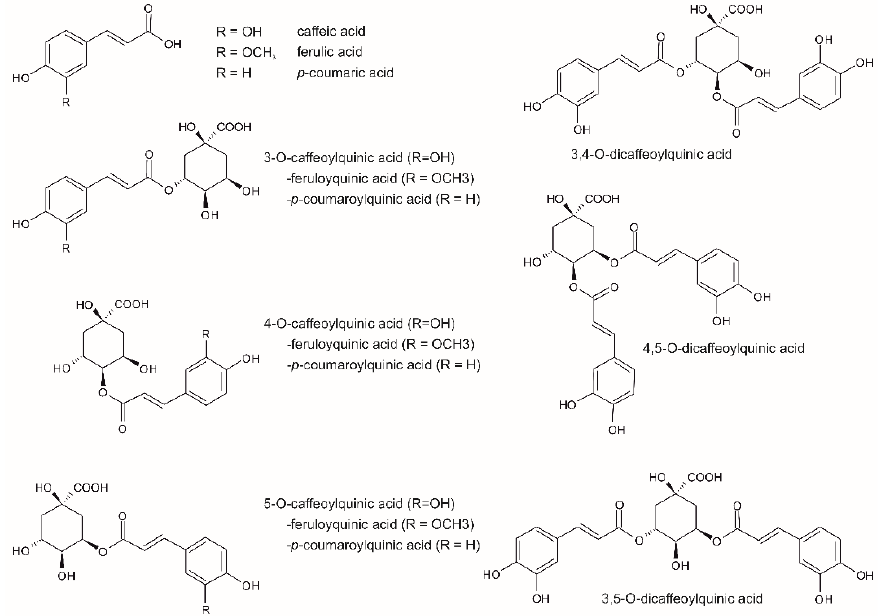
Figure 1. Structures of the most important chlorogenic acids present in coffee.